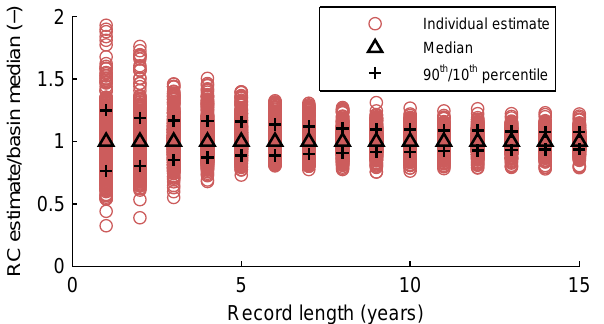
Fig. 2. Variation of runoff-coefficient estimates as a function of record length summarised for 37 basins with long data records. Esti- mates are standardised by division with the basin median for a given record length.